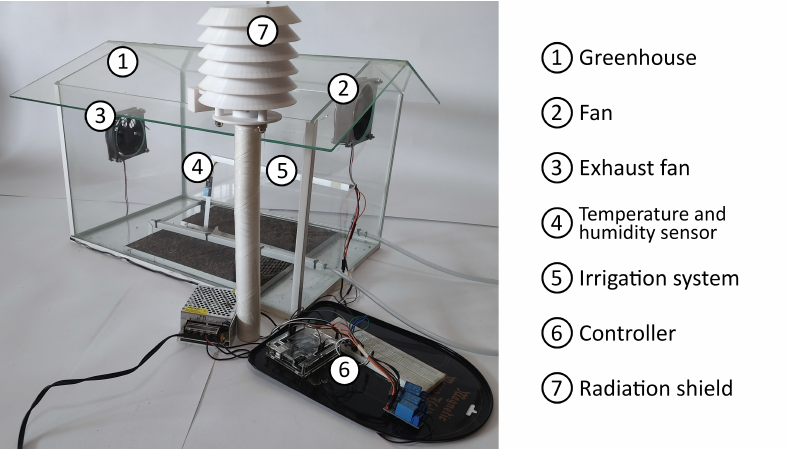
Figure 3. Prototype automated greenhouse utilized as case study. In the figure, the different compo- nents are indicated with